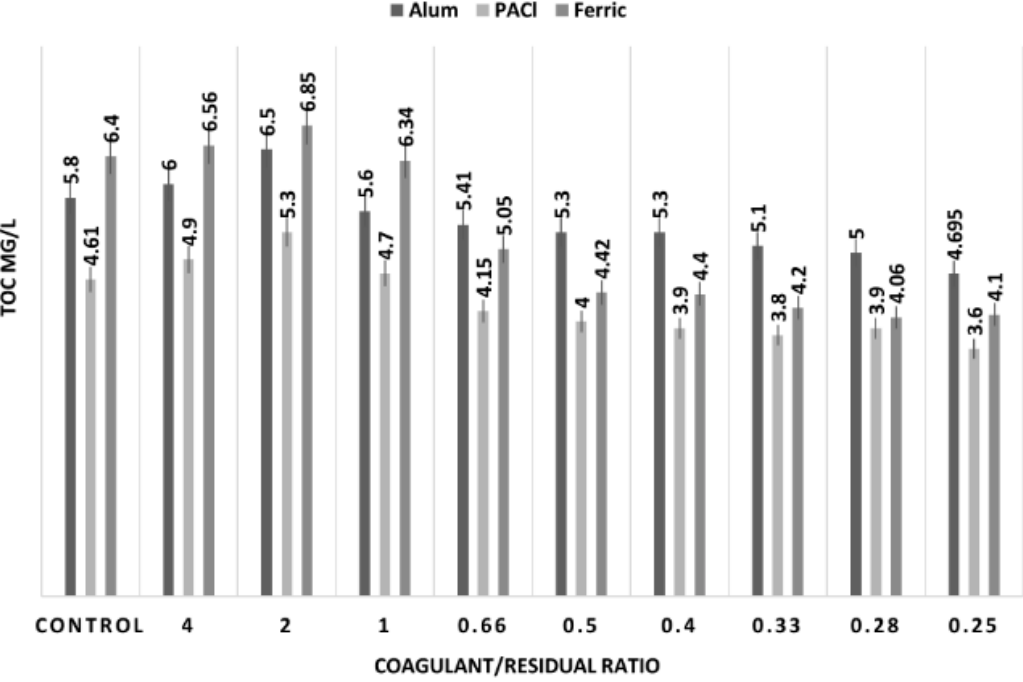
Figure1. Surfacewatertotalorganiccarbon(TOC)removalusingninecoagulant-to-residual(C / Figure 1. Surface water total organic carbon (TOC) removal using nine coagulant-to-residual (C/R) ratios .